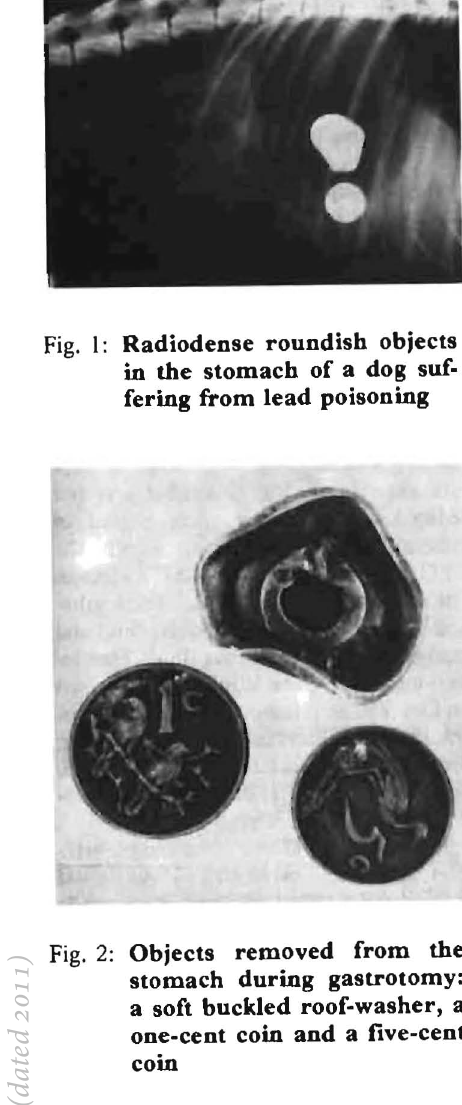
Radiodense roundish objects in the stomach of a dog suf fering from lead